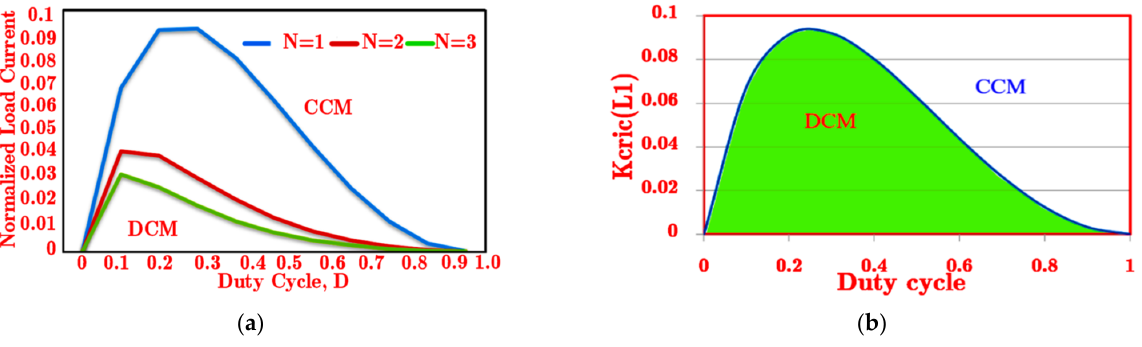
Figure 7. ( a ) Critical Inductor (K cric(L1) ) vs. different duty cycle (D) for HSIVL converter. ( b ) Normal- ized load current at the boundary between CCM and DCM for HSIVL converter.